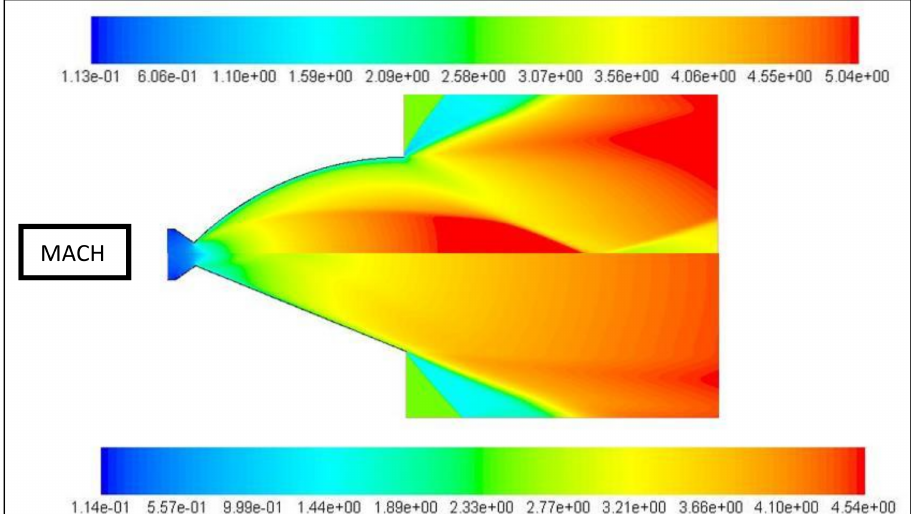
Figure 21. Pressure contour of bell nozzle ( top ) and conical nozzle ( bottom ).